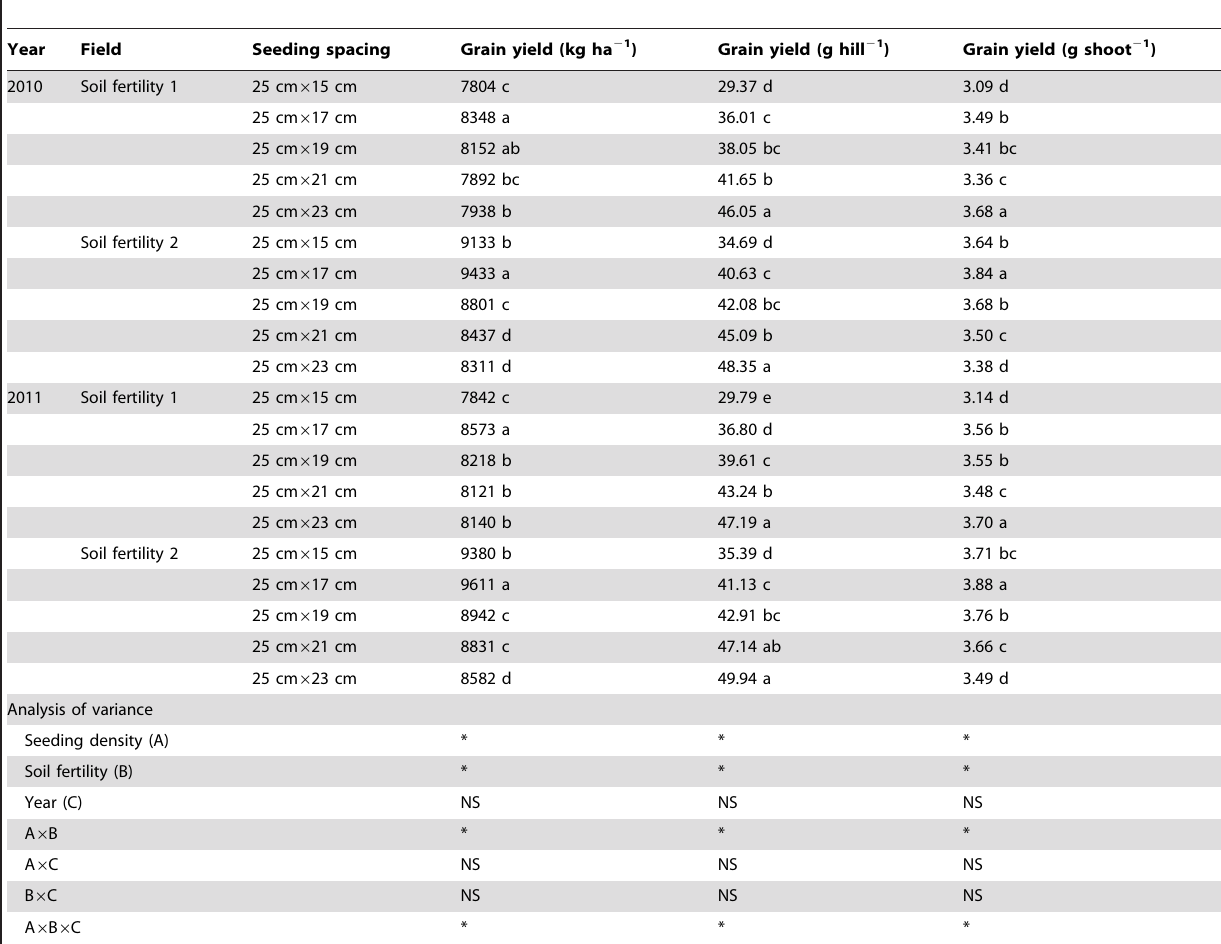
Table 1. Grain yield of a high-yielding hybrid rice variety Nei2you6 grown at five seeding spacings in soil fertility 1 and soil fertility 2 at the China National Rice Research Institute, Zhejiang Province, China, in 2010 and